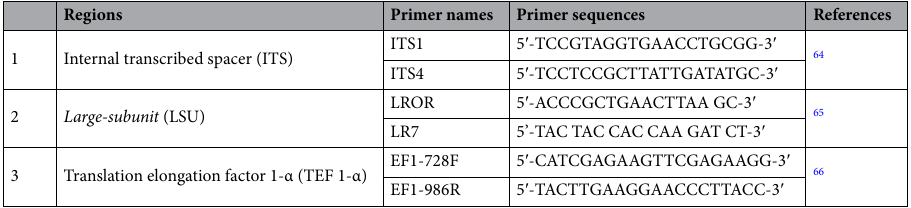
Table 1. Sequences of the primers used for PCR